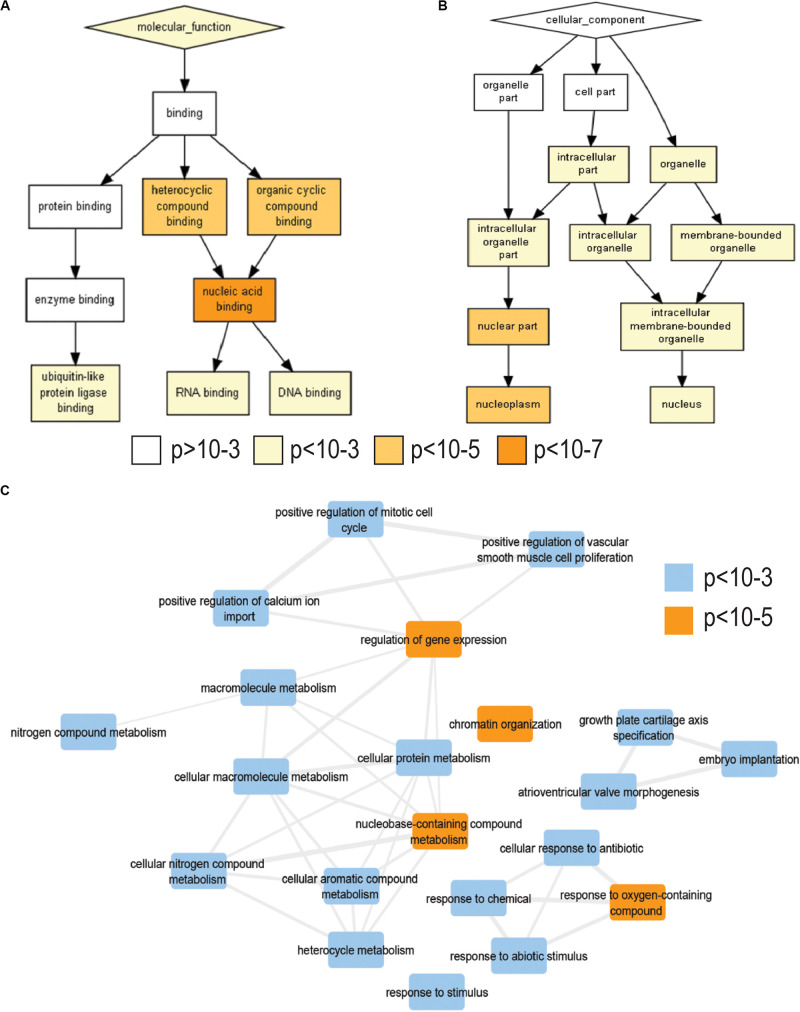
Gene Ontology enrichment analysis of RNA-sequencing data. (A) Gene Ontology molecular functions enriched in our differentially expressed genes from rotenone-treated HEK293 cells. (B) Gene Ontology cellular component enriched. Color gradient indicates enrichment p-value: white, >10– 3; yellow, 10– 3–10– 5; light orange, 10– 5–10– 7; dark orange, <10– 7. Enrichment p-value and adjusted FDR for each term are listed in Supplementary Tables 5, 6. (C) Network analysis of significantly enriched biological processes. Blue boxes enrichment p-value < 10– 3 and orange boxes enrichment p-value < 10– 5. Rotenone treatment changes the expression of genes involved in transcription factor signaling in the nucleus.